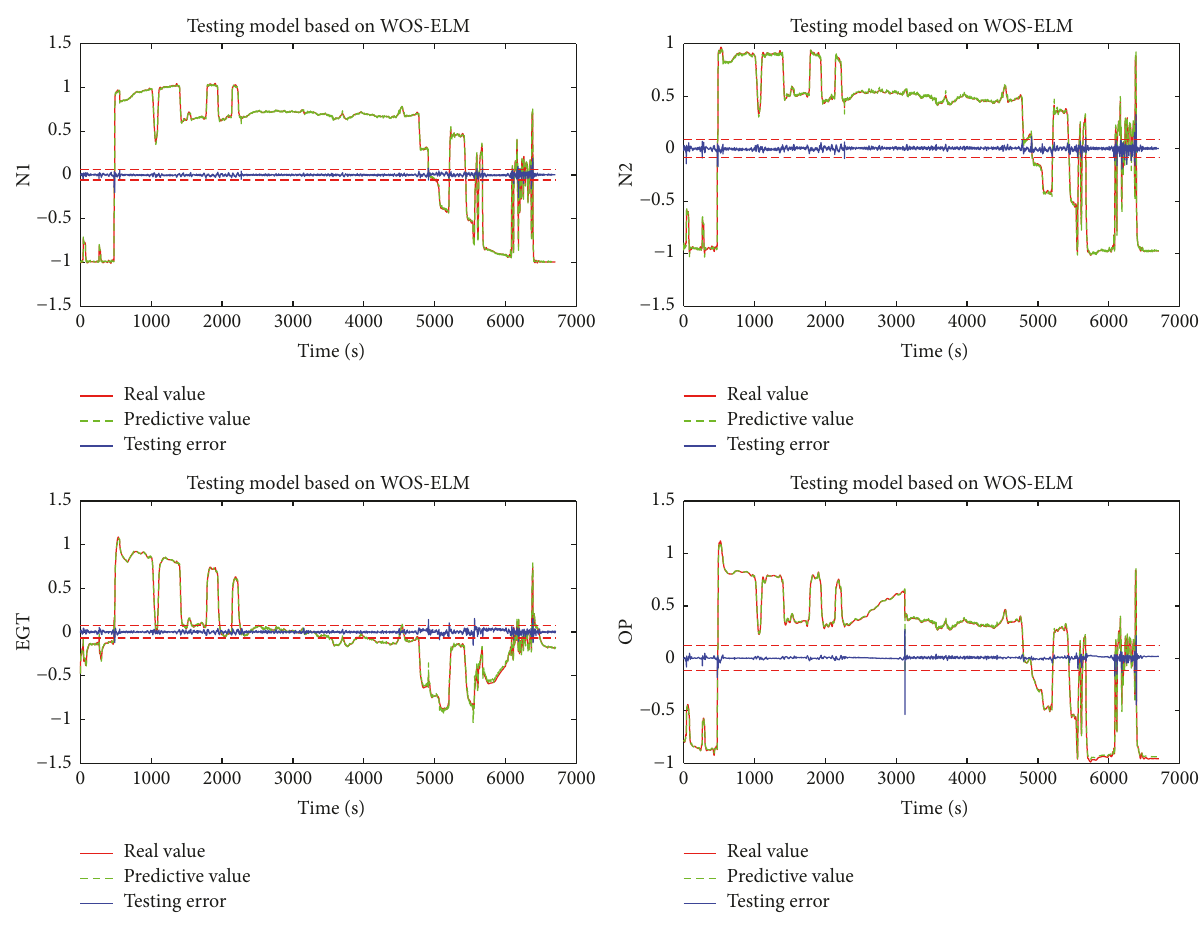
Figure 14: Time redundancy results after